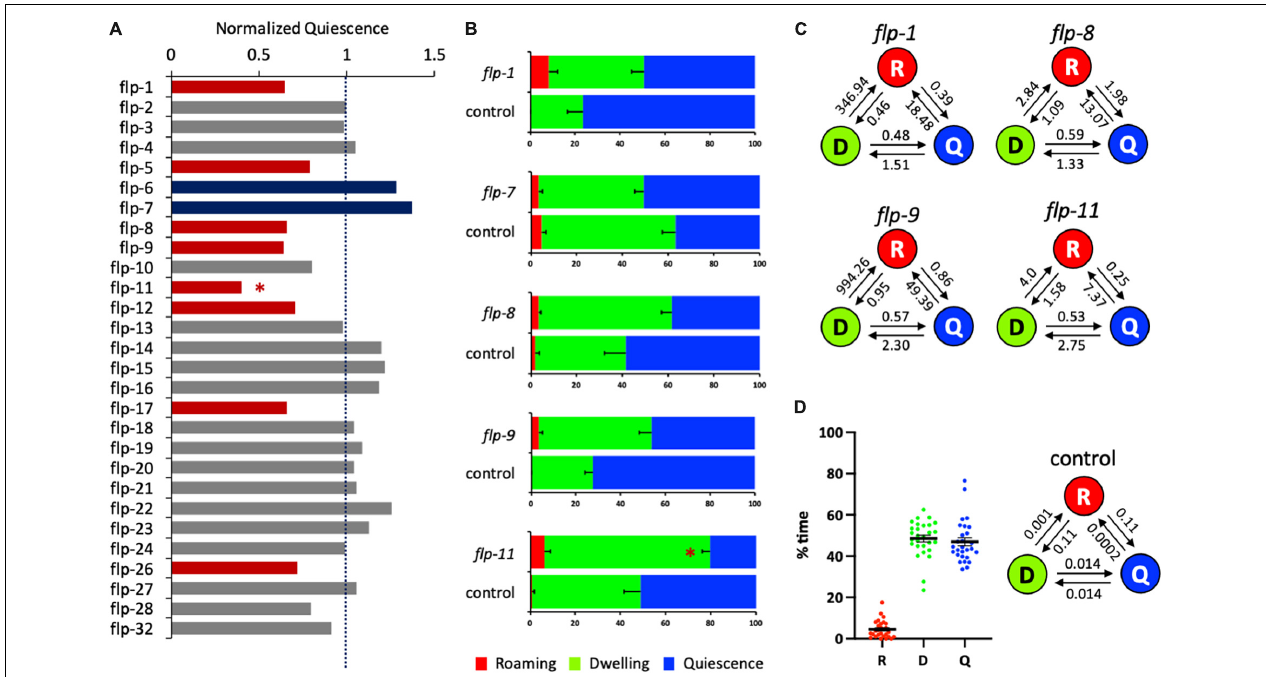
FIGURE 1 | Several flp genes regulate satiety quiescence. (A) The normalized time in quiescence after knockdown of individual flp genes by RNA interference. The percent time in quiescence of each flp is normalized to the percent time in quiescence of the concurrent control (RNAi vector only). Each RNAi was performed with the sample number of 15–18 of tested animals with 7–9 control animals. Red bars indicate that RNAi of the gene reduced satiety quiescence, whereas blue bars indicate that RNAi of the gene enhanced satiety quiescence with an approximate cut-off by ± 20% of the normalized value (see Table 1 ). (B) The individual data of the flp genes including whose RNAi showed significant changes in satiety quiescence. After two generations of feeding RNAi, the age-synchronized 1-day-old adults were tested for their locomotive activity by measuring the percent time they spent in roaming, dwelling and quiescence. (C) The transition rates of the animals treated with RNAi of flp-1, flp-8, flp-9, and flp-11 . The circles of R, D, and Q represent each state of roaming, dwelling, and quiescence, respectively. The rates are shown above the arrow that indicates the direction of transition. (D) Distribution of the values of each state (left) and average transition rates (right) of the 28 independently tested RNAi control groups. ( ∗ p < 0.009 by Student’s t -test after the Bonferroni correction. The error bars indicate